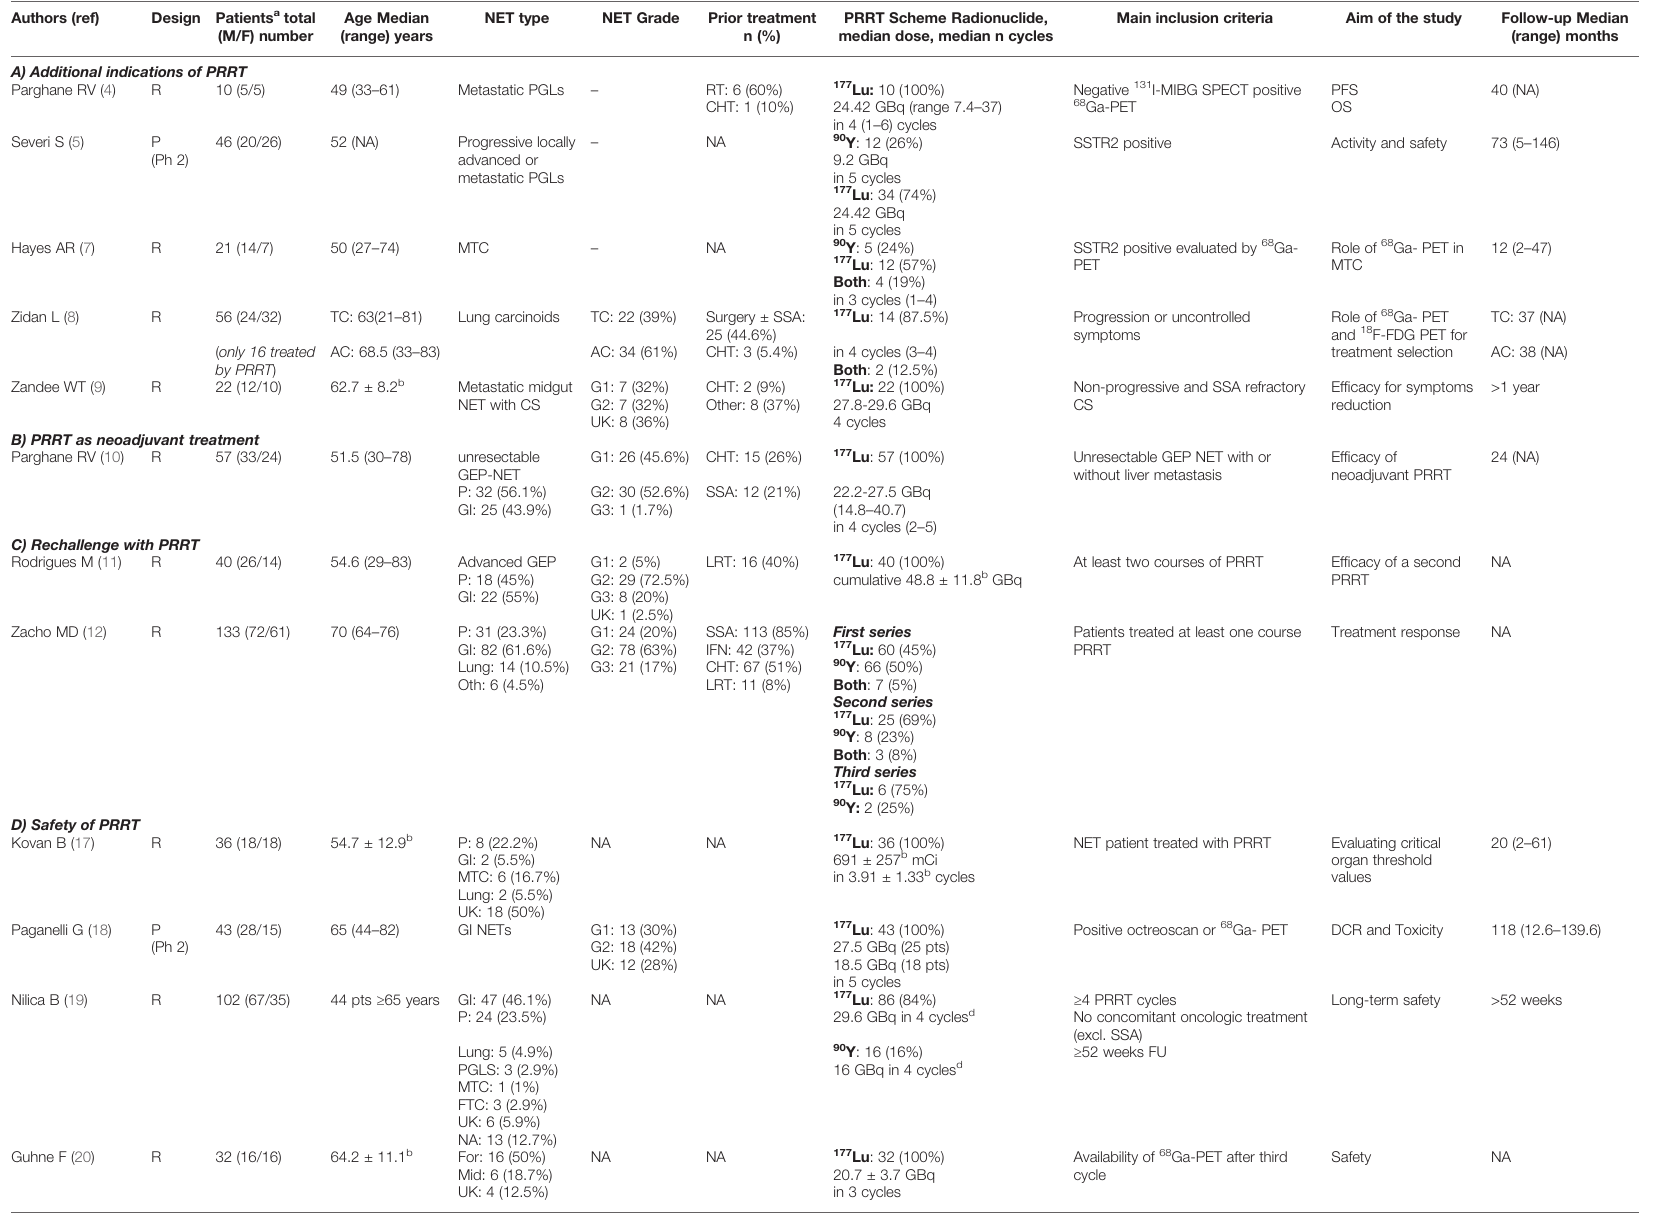
TABLE 1 | List of the main studies published in 2021 on (A) additional indications, (B) neoadjuvant role, (C) rechallenge, and (D) safety of PRRT treatment in patients affected by NETs. Authors